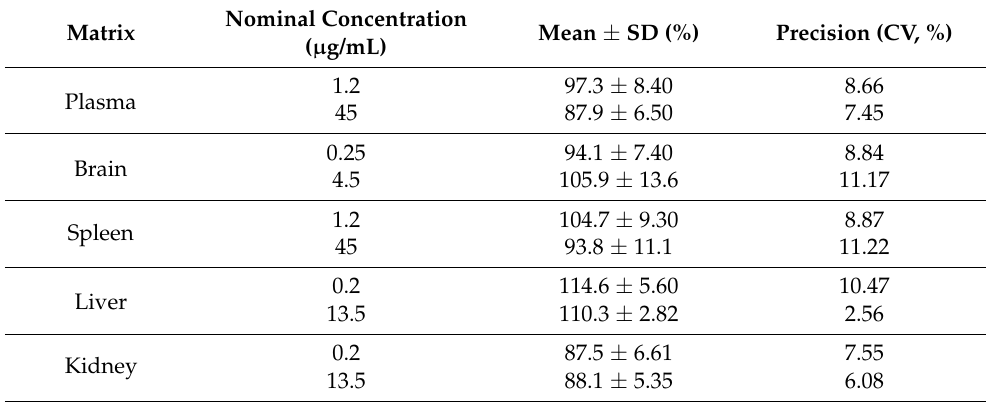
Table 6. Stability of celecoxib at medium and high concentrations of the calibration range in processed mouse matrices under room temperature for 24 h (n =